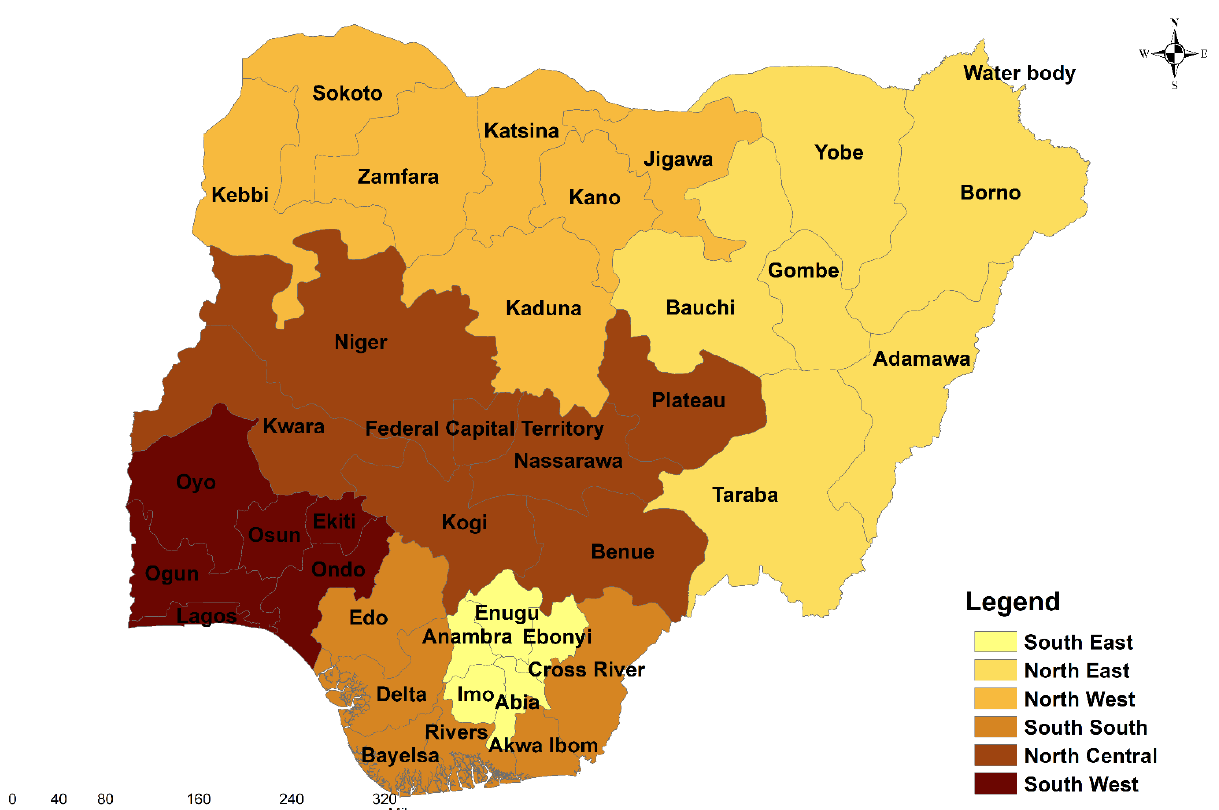
Figure 1. Map of Nigeria showing the six geopolitical zones, the constituent 36 states and the Federal Capital Territory (FCT), Abuja.